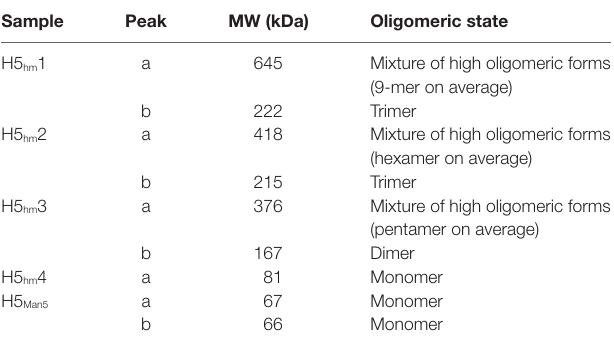
Table 2 ). All the chromatograms with theoretical stoichiometry predicted based on SEC-MALS results were overlaid and are presented in ( Figure 4F